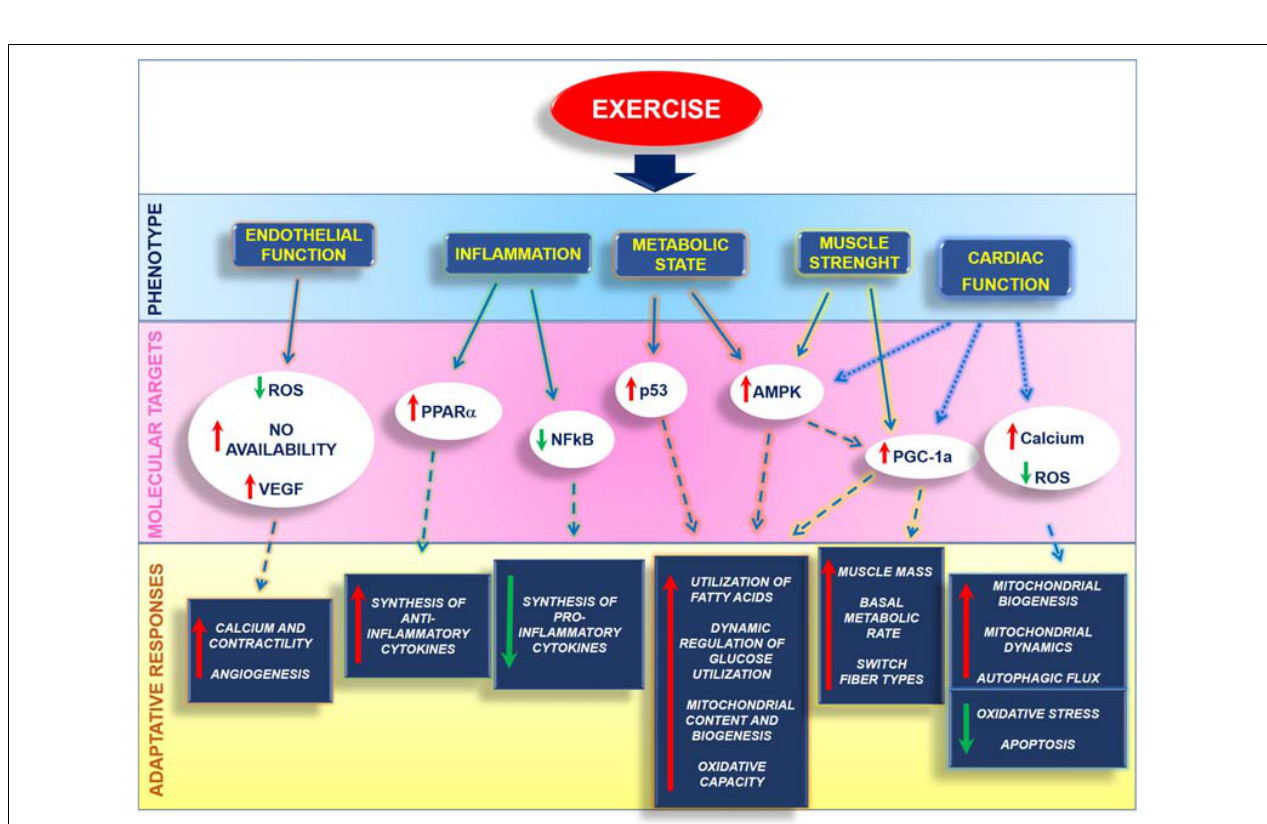
FIGURE 5 | Exercise affects several phenotypes within the cell by activating different molecular mechanisms that orchestrate the adaptative responses of organ and tissues.